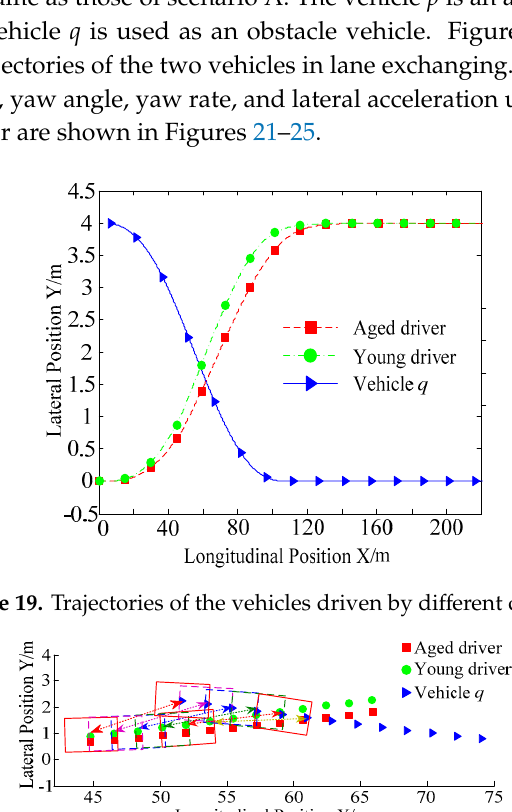
Figure 18. Lateral acceleration of vehicle p .